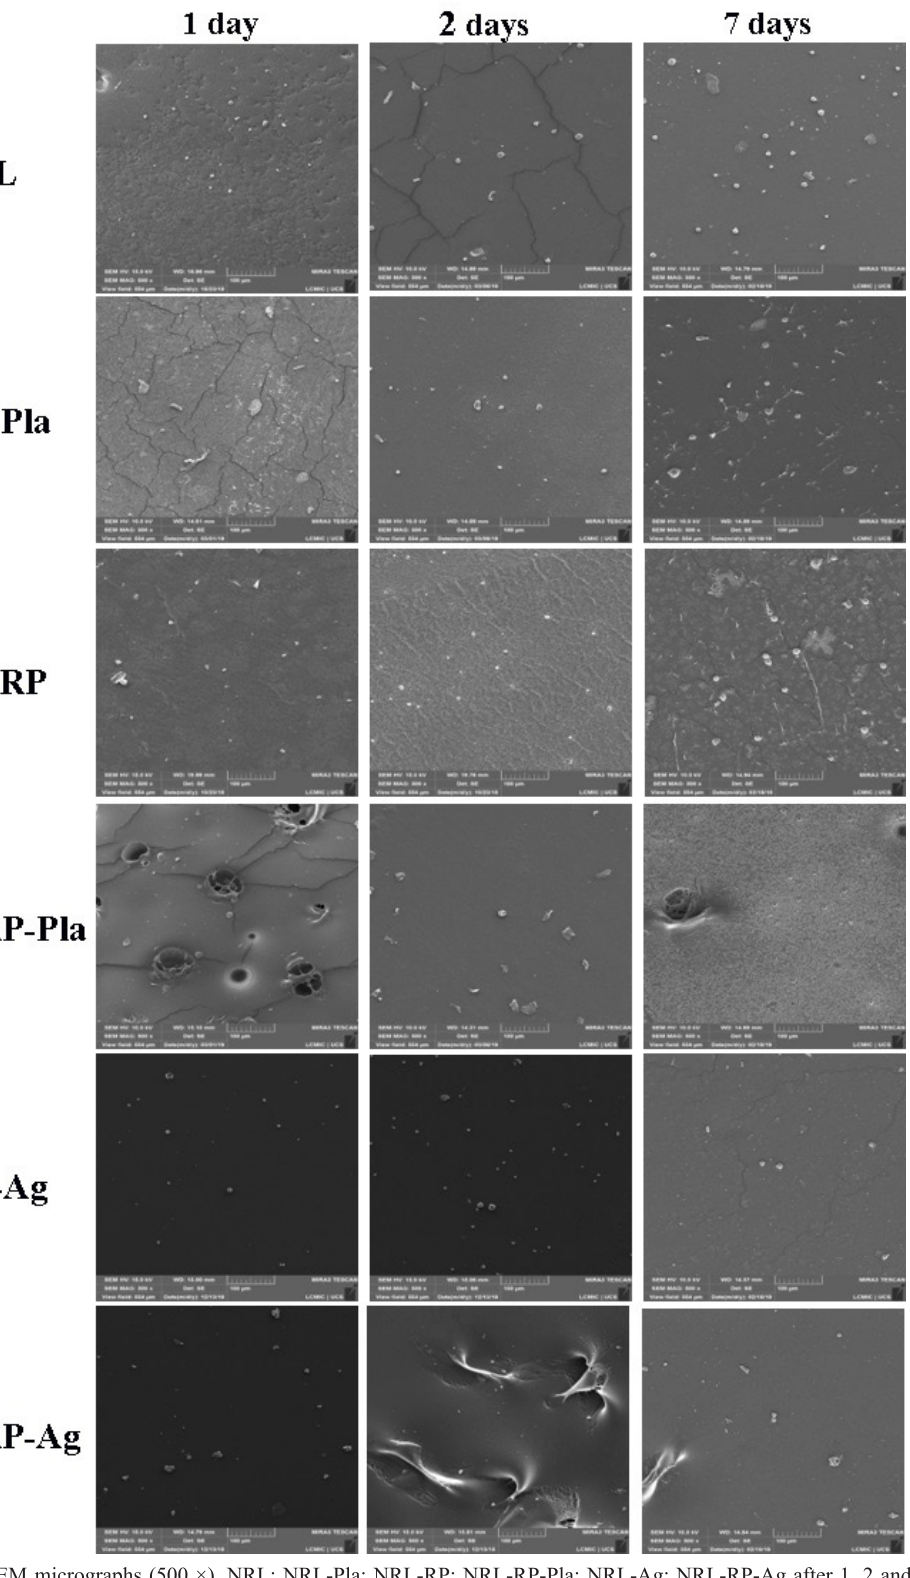
Figure 9. FEG-SEM micrographs (500 ×). NRL; NRL-Pla; NRL-RP; NRL-RP-Pla; NRL-Ag; NRL-RP-Ag after 1, 2 and 7 days ADSCs cellular